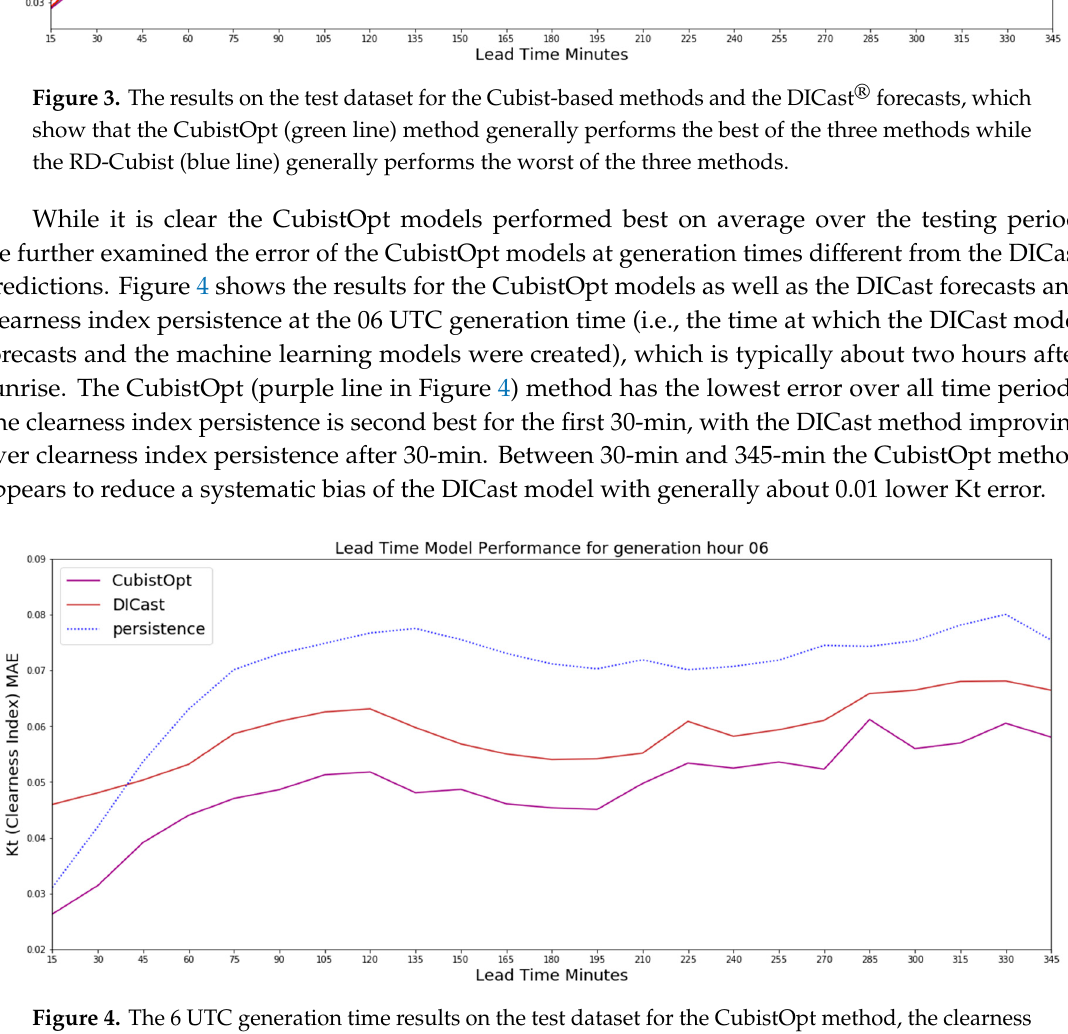
Figure 4. The 6 UTC generation time results on the test dataset for the CubistOpt method, the clearness index persistence, and the DICast forecasts, which show that the CubistOpt (purple line) method has the lowest error over all time periods.